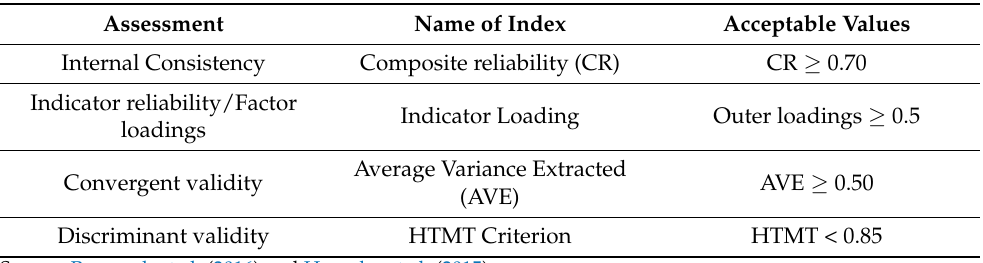
Table 2. Acceptable Values for Model Evaluation—Measurement Model